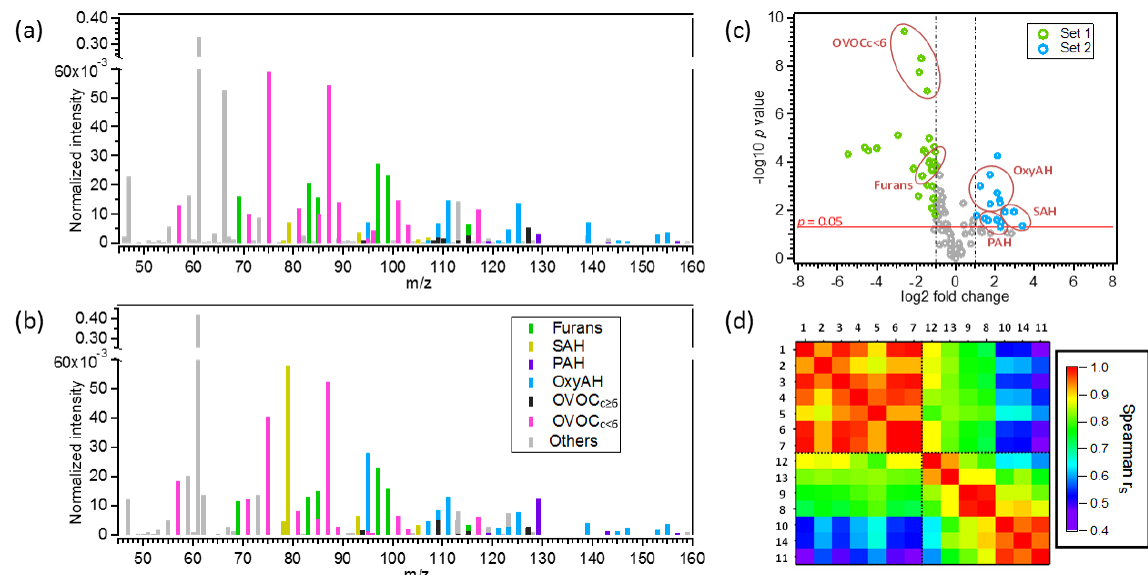
Figure 2. Comparison of the OG emissions between the two sets of experiments. Panels (a) and (b) display average primary OG mass spectra from Set 1 (representing the smoldering phase) and Set 2 (representing mainly the flaming phase), respectively. Spectra are normalized to the initial total OG concentration in micrograms per cubic metre. Compounds are colour coded by chemical classes. (c) The p value vs. fold change comparing the fingerprints of primary OGs between the two sets of experiments. The fold change was calculated as the ratio of the intensities of each ion normalized to the total signal, between Set 2 and Set 1 averaged across experiments. Data points above p = 0 . 05 have significantly different contributions to the total OGs between the two sets of experiments. Blue coloured data points on the right-hand side designate compounds enriched in the emissions from Set 2 while green coloured data points on the left-hand side designate compounds enriched in the emissions from Set 1. (d) Spearman correlation matrix for the primary OG mass spectra between all experiments highlighting the variability in the composition of the primary emissions. Each experiment is identified by an index (see Table 1) and the experiments from Set 2 were reordered according to similarity with Set